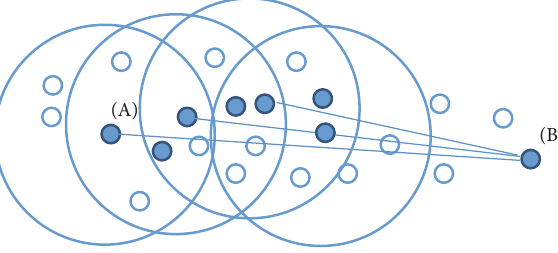
Figure 5: Results of the following slices.